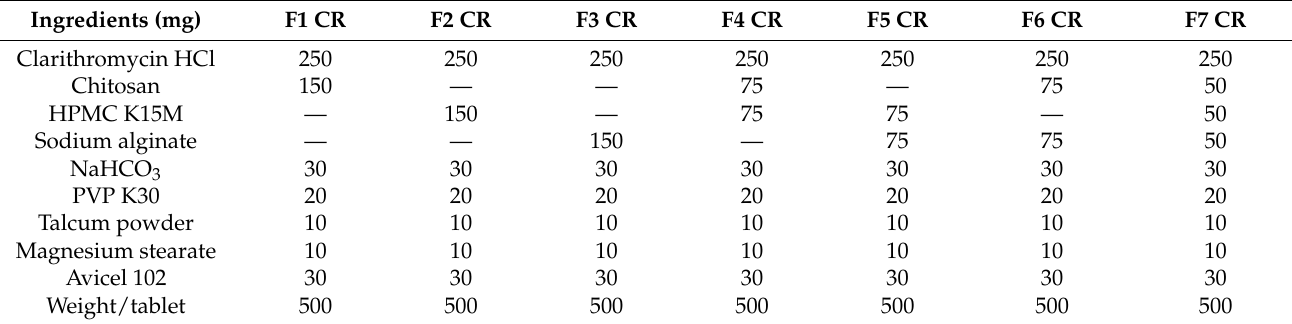
Table 7. Ingredients of the slow-release floating layer of